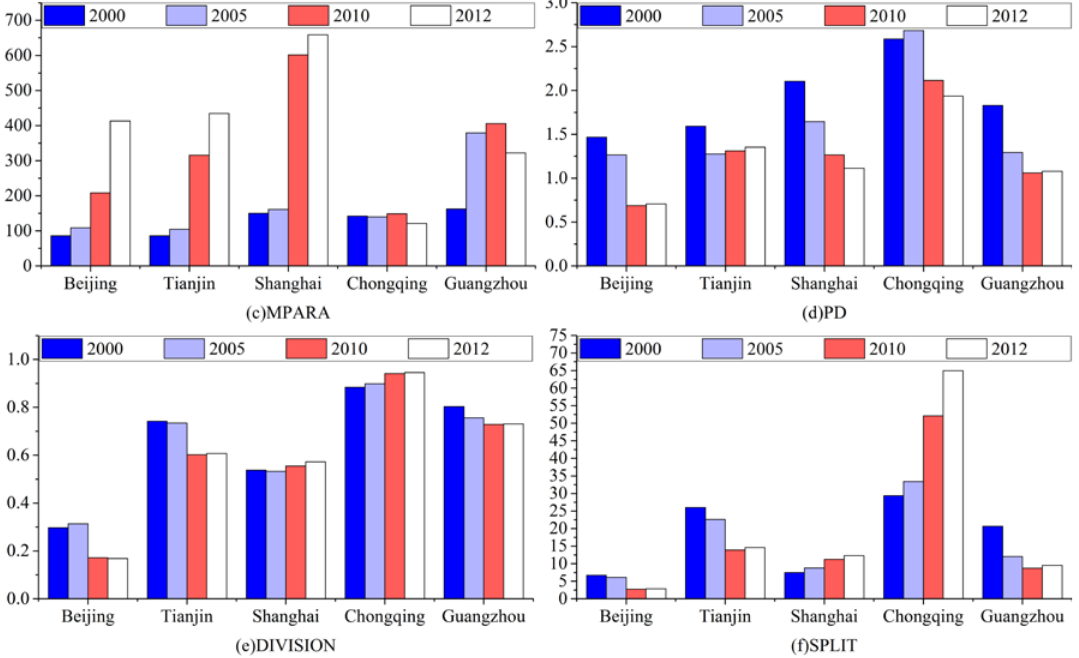
Figure 5. Changes in landscape metrics in five Chinese megacities, 2000–2012: ( a ) PAFRAC; ( b ) AWMFDI; ( c ) MPARA; ( d ) PD; ( e ) DIVISION; ( f )